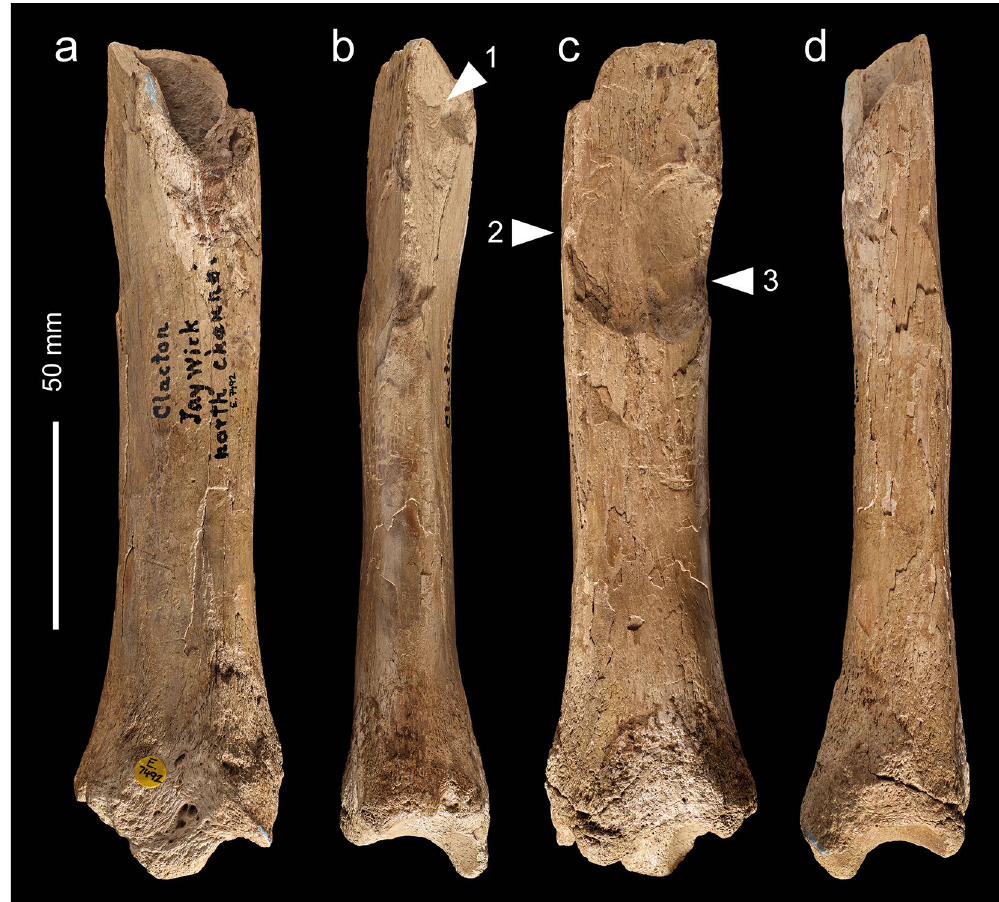
Figure 7. Red deer tibia (NHMUK PA E 7492) in anterior ( a ), lateral ( b ), posterior ( c ) and medial ( d ) view. The arrows indicate the direction and sequence of impacts that removed the cortical